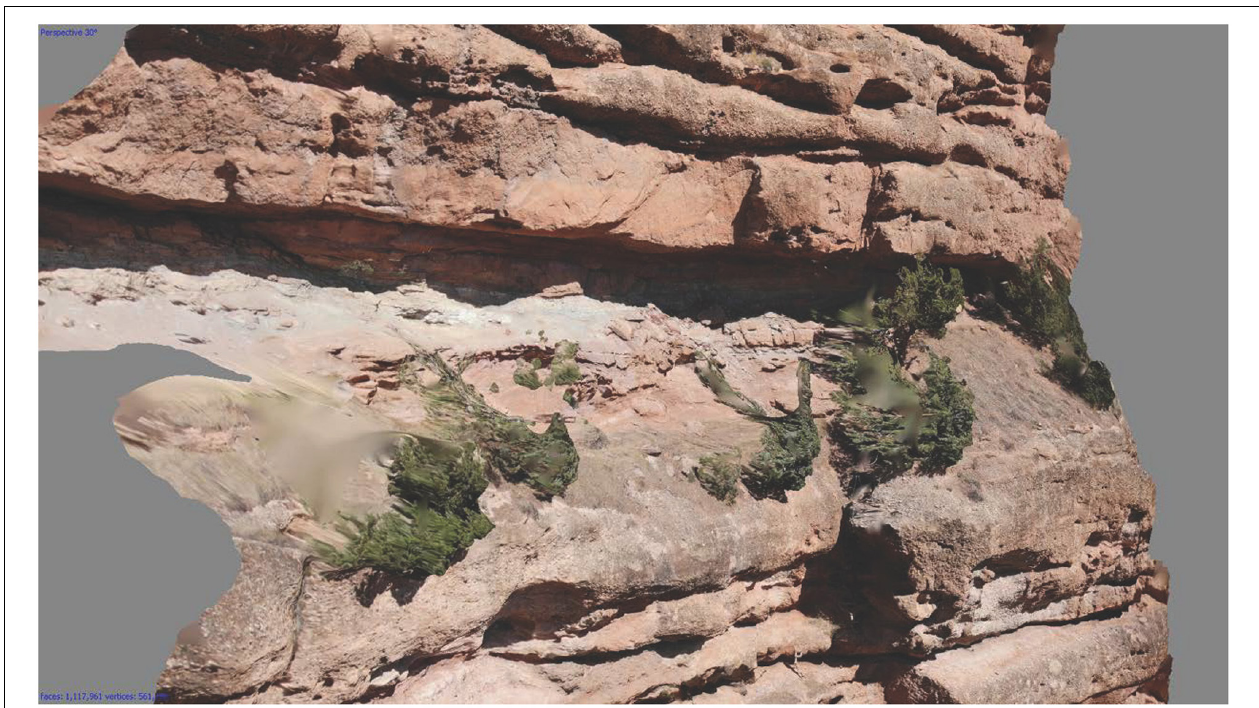
FIGURE 9 | Close-up view the “Detailed Section” digital outcrop model from Echo Canyon (available in the data repository). Fourth-order lithosomes can be clearly seen as individual beds in the conglomerates at the top and bottom of the image. In the middle of the image is a light-colored, recessive unit that consists of green and red fine-grained, thinly bedded sandstones as well as structureless mudstones interpreted as paleosols. The top of this recessive unit corresponds to a fifth-order bounding surface. See juniper trees for